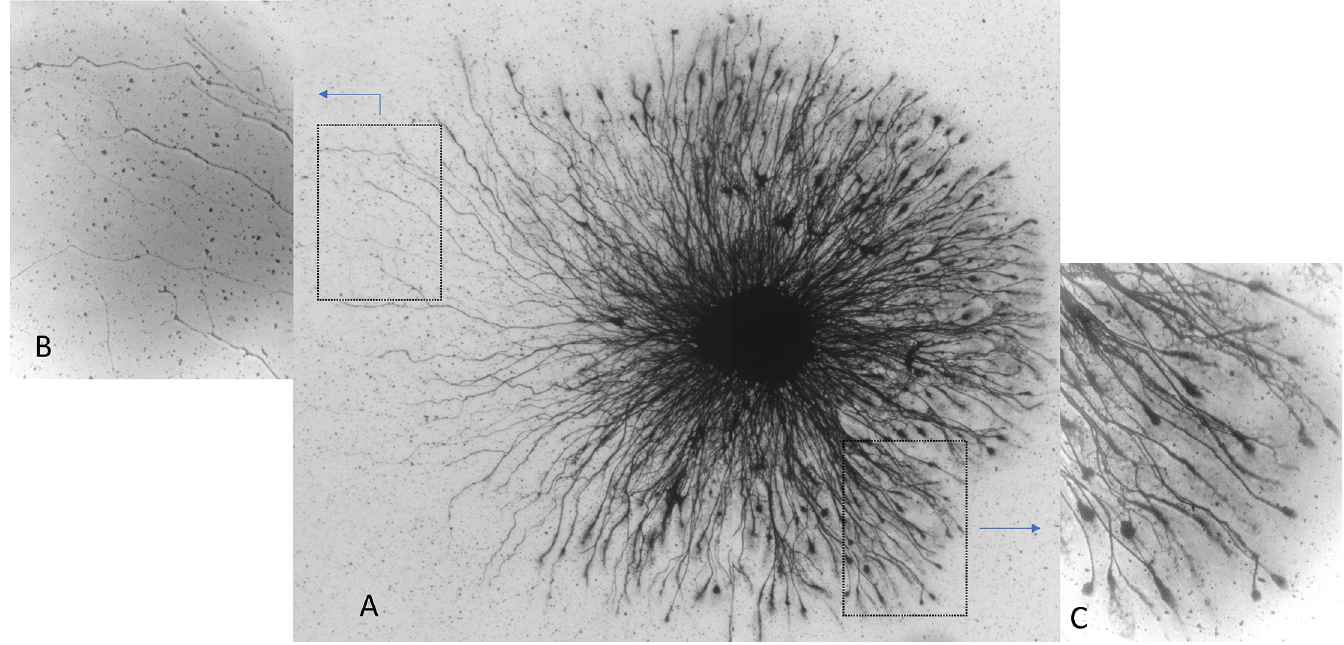
Fig 2. An example of neurite outgrowth from an embryonic chick sympathetic ganglion explant stained with silver. The neurite halo shows asymmetric neurite growth [A] such that the neurites on the left side are longer and thinner [B] than those on the right side, which also have distinct club-like endings [C].